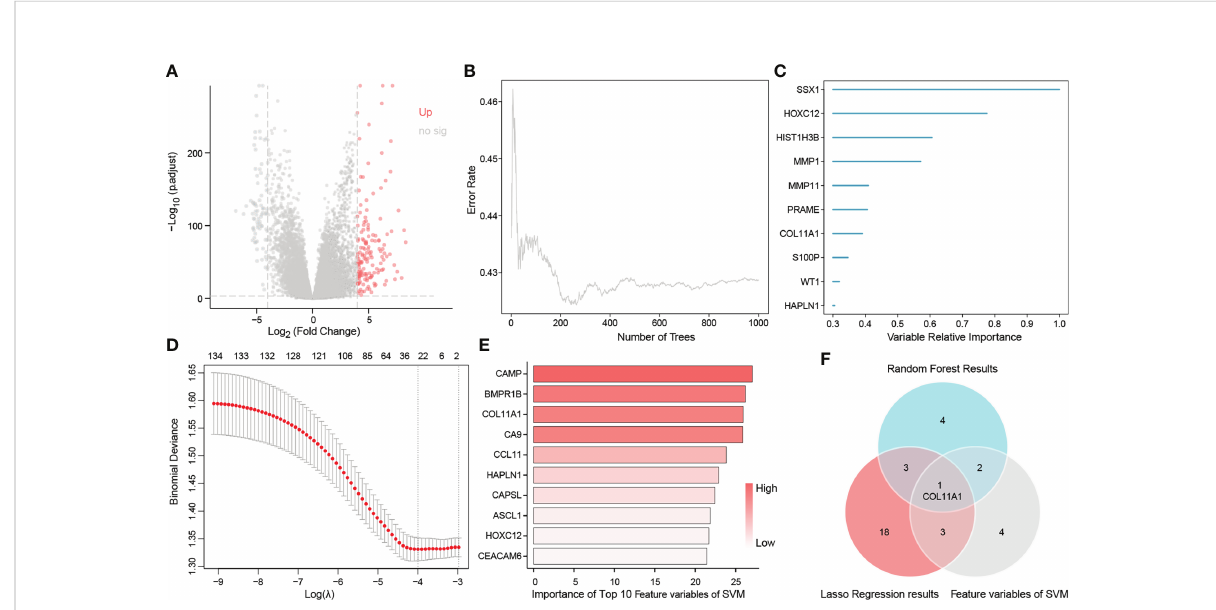
FIGURE 2 Identi fi cation of COL11A1 as a core gene. Volcano showing up-regulated genes (A) , random survival forest identi fi ed genes of importance associated with patient prognosis (B, C) , lasso regression analysis screened feature genes with patient prognosis (D) , and support vector machine screened the top 10 feature support vectors associated with prognosis (E) , Wayne diagram showing the core genes common to the three machine learning methods COL11A1 (F)